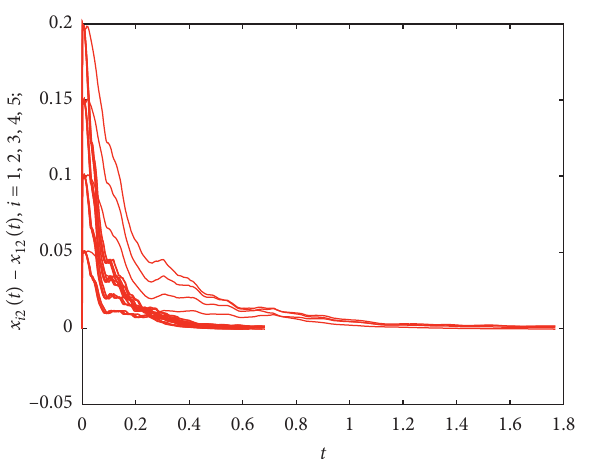
Figure 2: The synchronization error trajectories of x in Example 1.